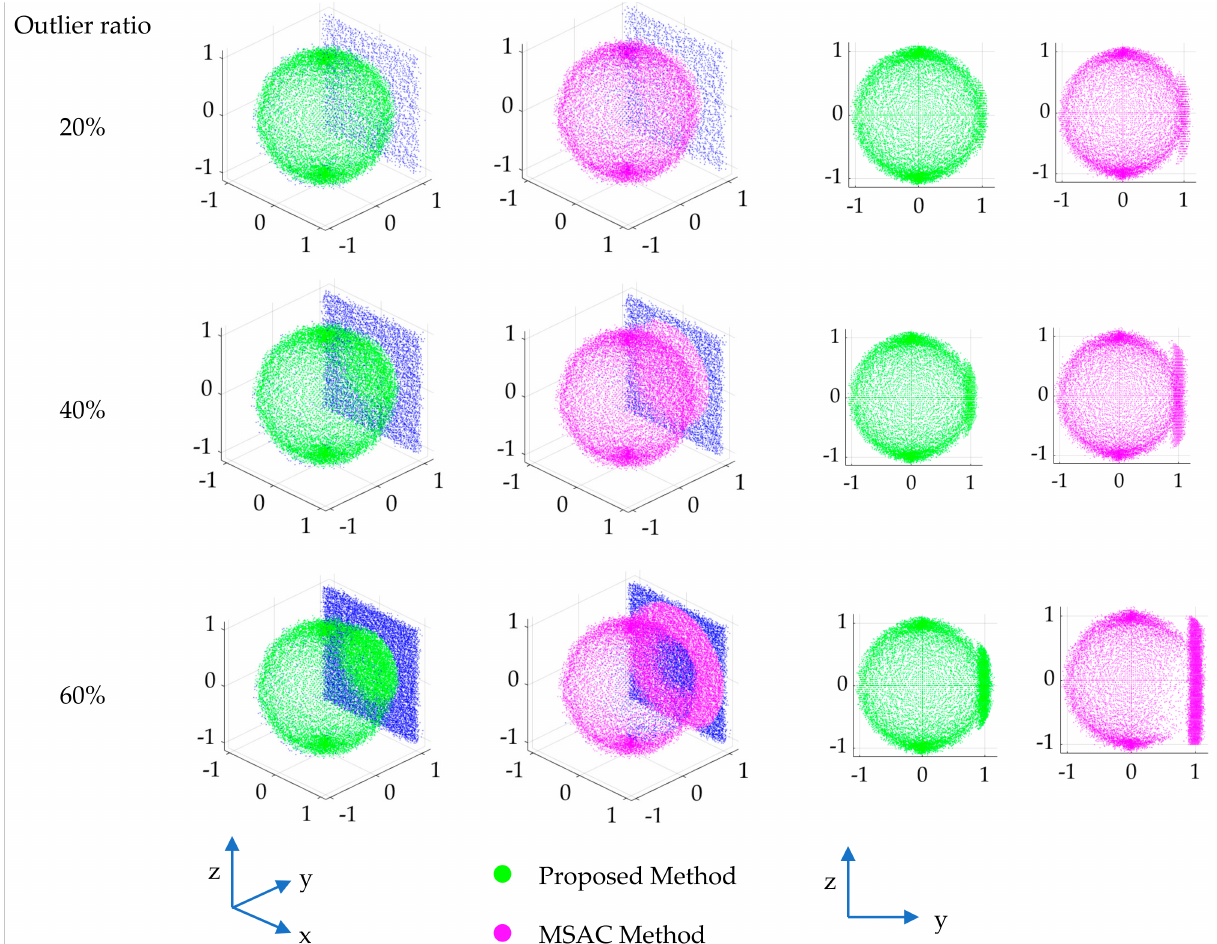
Figure 6. Results of the detected spherical points with outlier ratios of 20%, 40%, and 60% using the proposed (green) and MSAC (magenta) methods in orthographic ( left ) and side ( right )